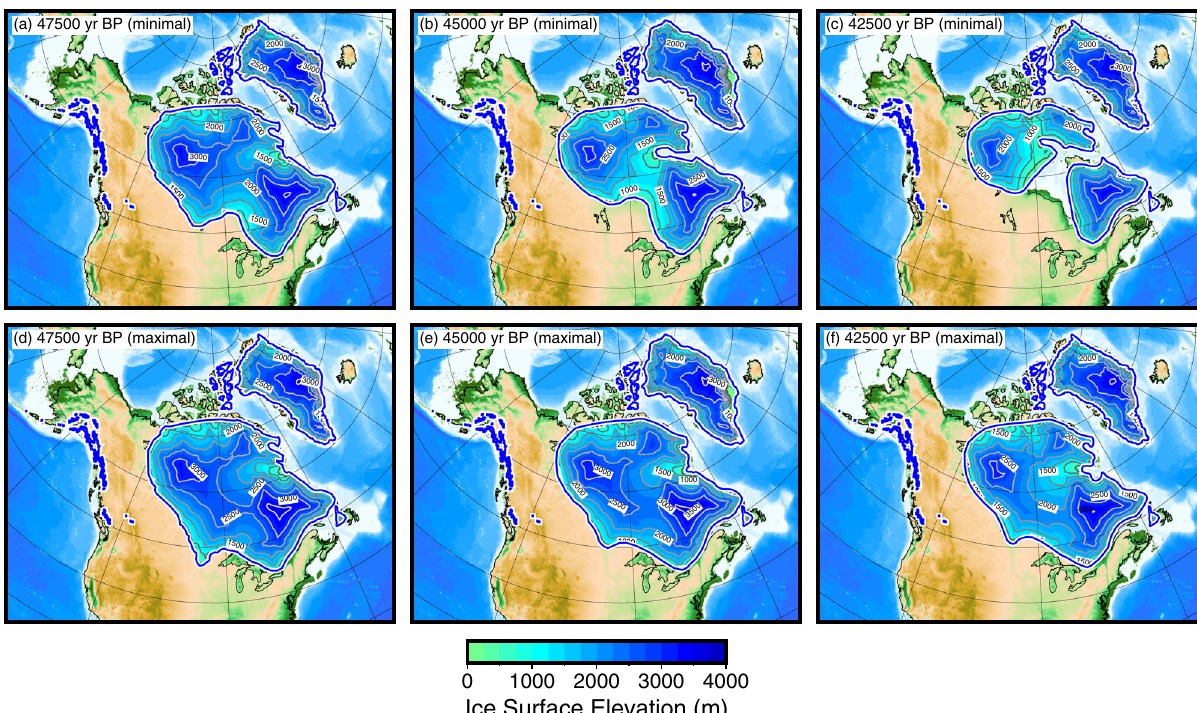
Fig. 1 Reconstruction of North American ice sheets during Marine Isotope Stage 3. a 47,500yr BP — minimal scenario, b 45,000 yr BP, prior to Heinrich Event 5 — minimal scenario, c 42,500yr BP, after Heinrich Event 5 — minimal scenario with full deglaciation of Hudson Bay, d 47,500yr BP — maximal scenario, e 45,000 yr BP, prior to Heinrich Event 5 — maximal scenario, f 42,500yr BP, after Heinrich Event 5 — maximal scenario with less retreat. The contour interval is 500